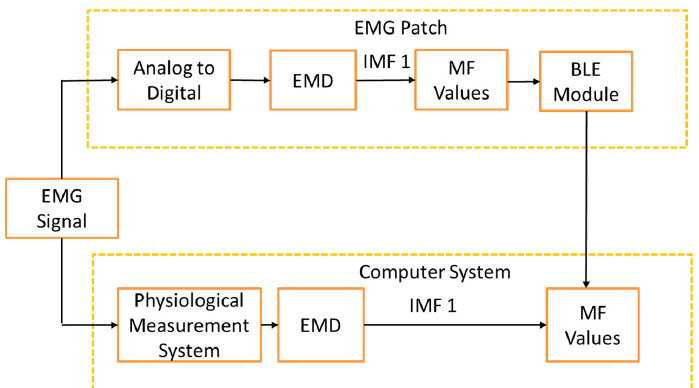
Figure 1. Block diagram of electromyogram (EMG) patch. MCU: micro controller unit; BLE: Bluetooth low energy.